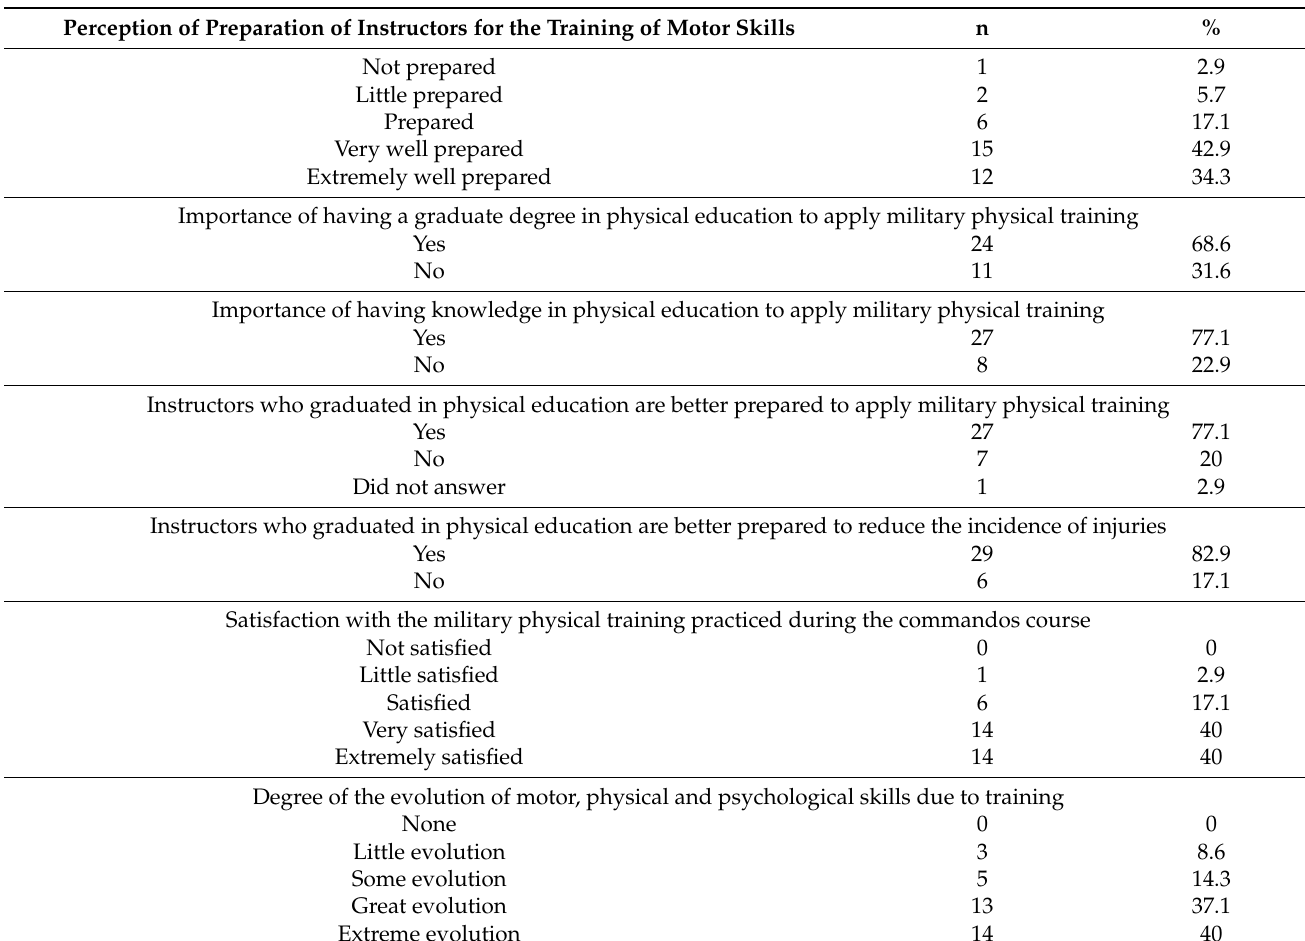
Table 3. Perception about instructors’ preparation and satisfaction with military physical